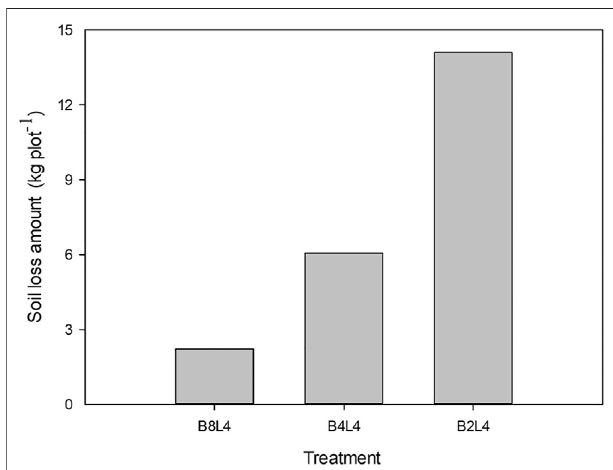
FIGURE 5 | Soil loss amount under different ratios of Salix residual branches and